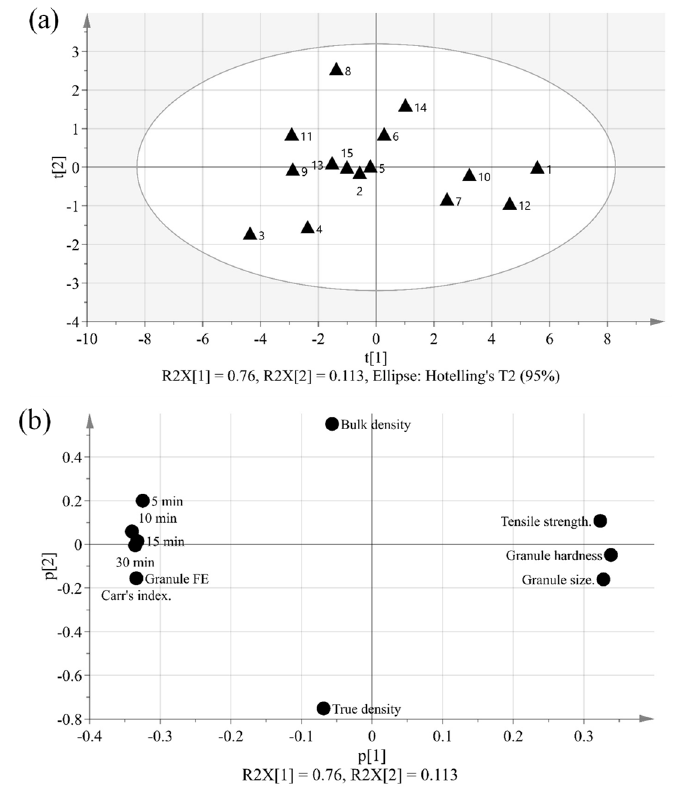
Figure 5. Cumulative R2 (R2X(cum)) and Q2 (Q2(cum)) of response factors (IQAs and CQAs) for two principal components.